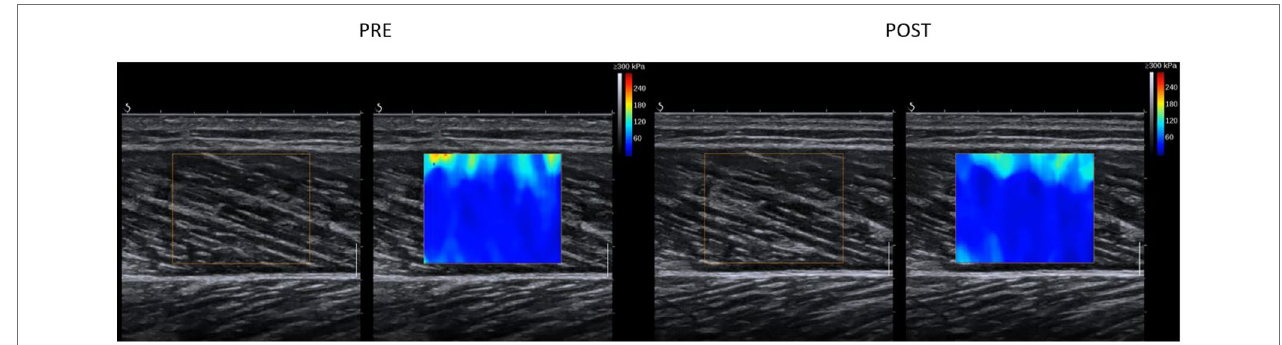
FIGURE 4 | An example for signal changes in shear wave elastography in the GM muscle in the PNF + PSA group. For the analysis, the area within the colored box was analyzed. Each colored pixel has a value according to the scale on the right upper corner (max 300 kPa) and the average of the chosen area was taken for further